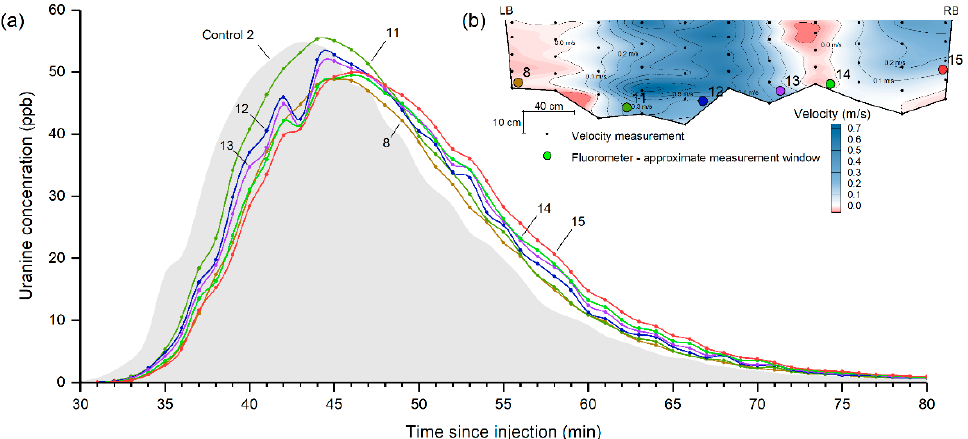
Figure 5. ( a ) Breakthrough curves for each fluorometer of cross-section 2. Control fluorometer is placed 10–15 m upstream of the section (Figure 1). ( b ) Velocity profile of cross-section 2 and location of the fluorometers (LB: left riverbank; RB: right riverbank).